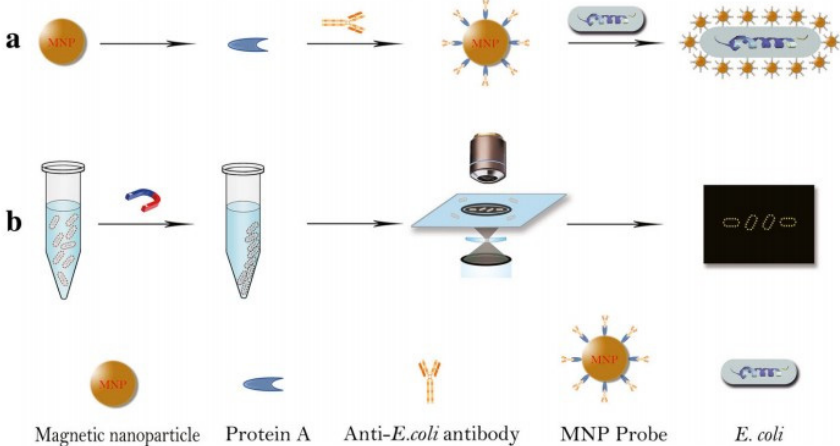
Figure 5. Schematic diagram of counting E. coli under dark-field, using antibody functionalization of MNP to form a gold ring structure around E. coli. ( a ) MNP probe was obtained by culture of E. coli antibody onto MNP. E. coli samples are first mixed with MNP probes to form probe- E. coli complexes. ( b )The complex of E. coli and MNP probes was separated by a magnet and then counted under a dark-field microscope. [119]. Adapted with permission from Ref. [119]. Copyright © 2018 The